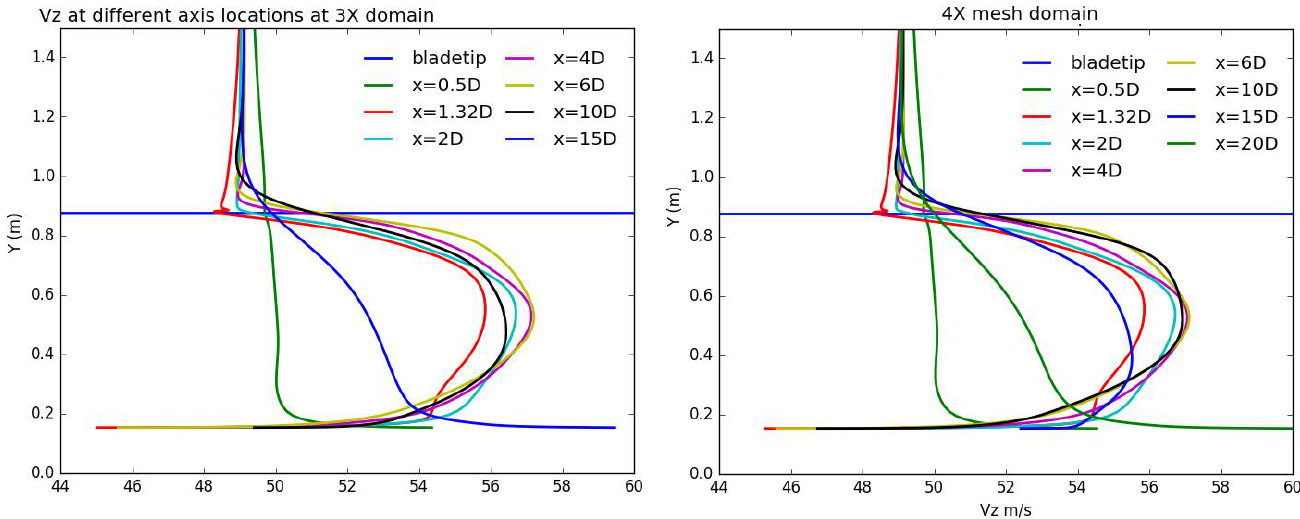
Figure 18. Mass-averaged Vz radial profiles downstream for 3X and 4X domains showing streamtube contraction with an inlet velocity of 49.17 m/s. Mixing occurs between 6–10D downstream where the velocity increase starts deteriorating.